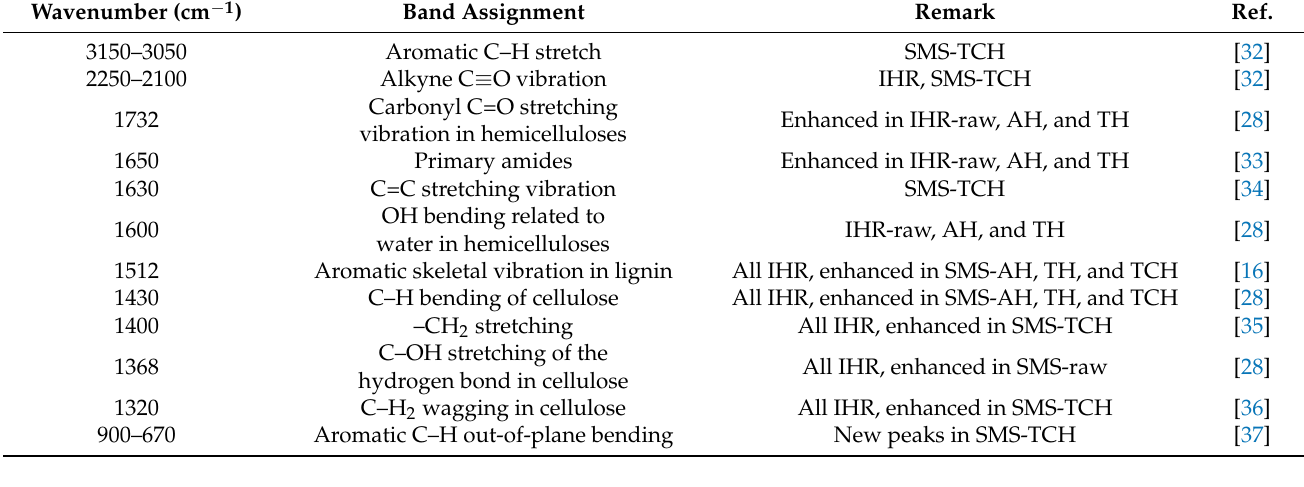
Table 2. Functional group assignments for raw materials and pretreated solid residues of IHR and SMS.